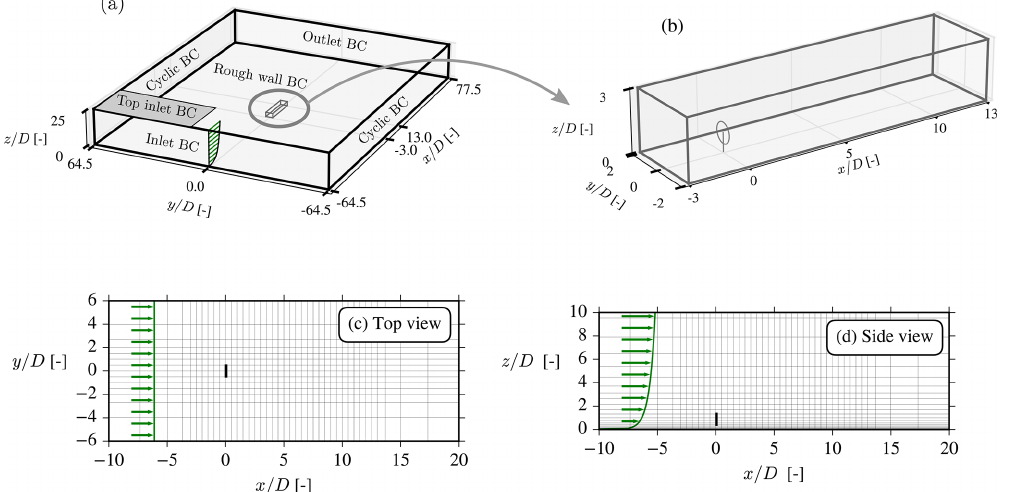
Figure 10. Flow domain (a) , finely resolved wake domain (b) , x – y cut at hub height (c) , and x – z cut at centerline (d) . Every fourth cell is displayed in panels (c) and (d) , and green arrows show velocity profile (not to